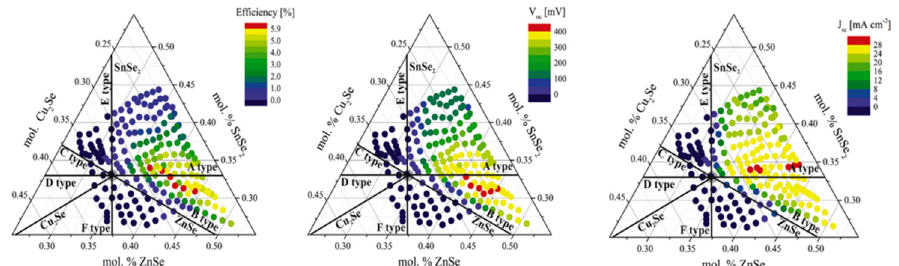
Figure 3. Combinatorial experiment showing the relationship of conversion efficiency and V OC with the composition of CZTS. Reprinted with permission from [10]. Copyright Elsevier.